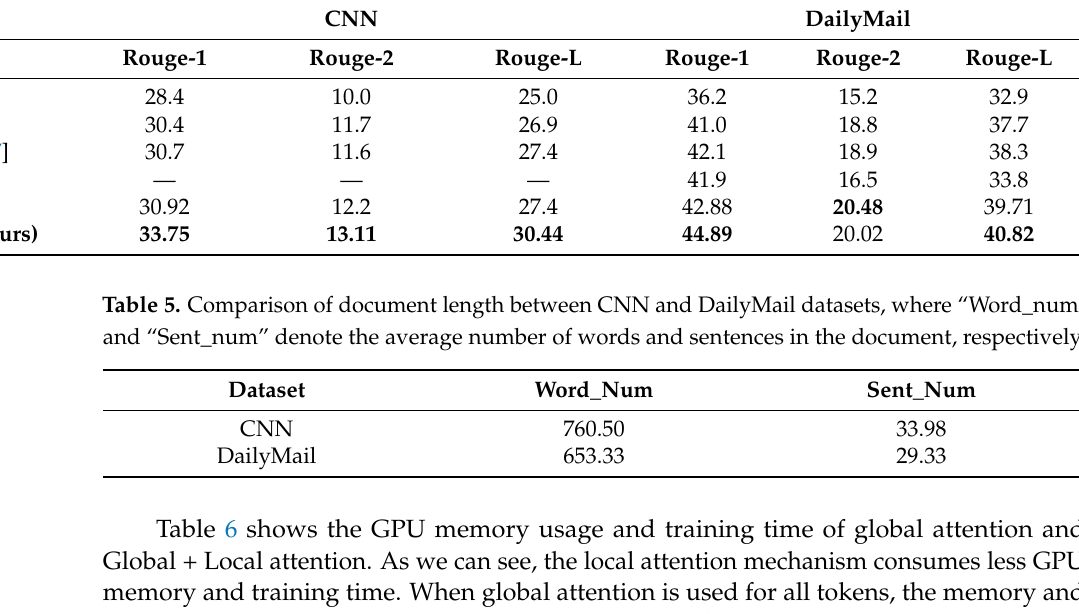
Table 6. GPU memory usage and training time of global attention and Global + Local attention.